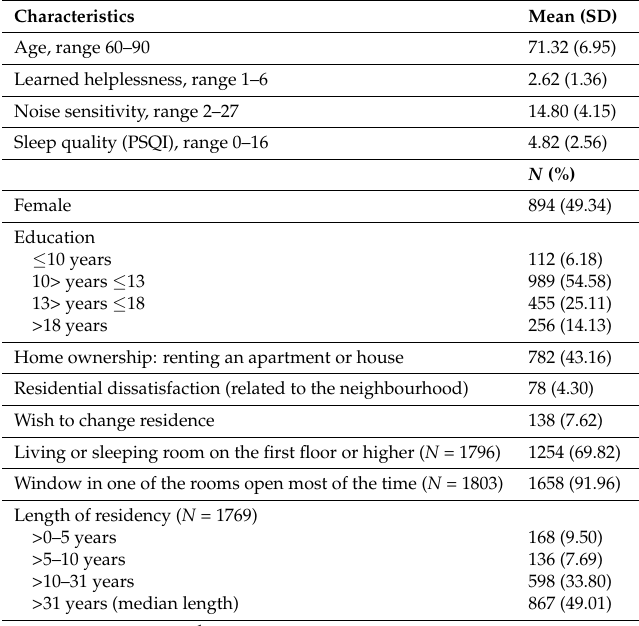
Table 1. Characteristics of the study sample, N = 1812 1 .